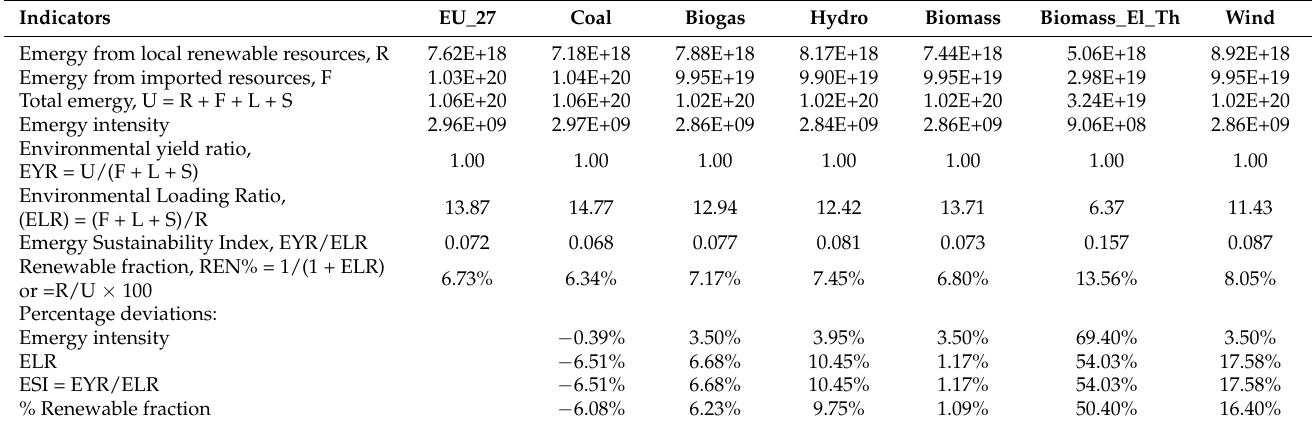
Table A2. Comparative analytic values of emergy flows and emergy-based indicators for the biodiesel production process using alternate energy resources.